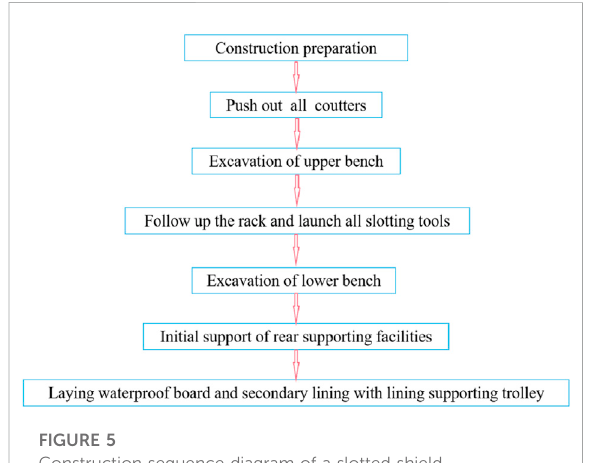
Sketch map of slotted shield tunneling.